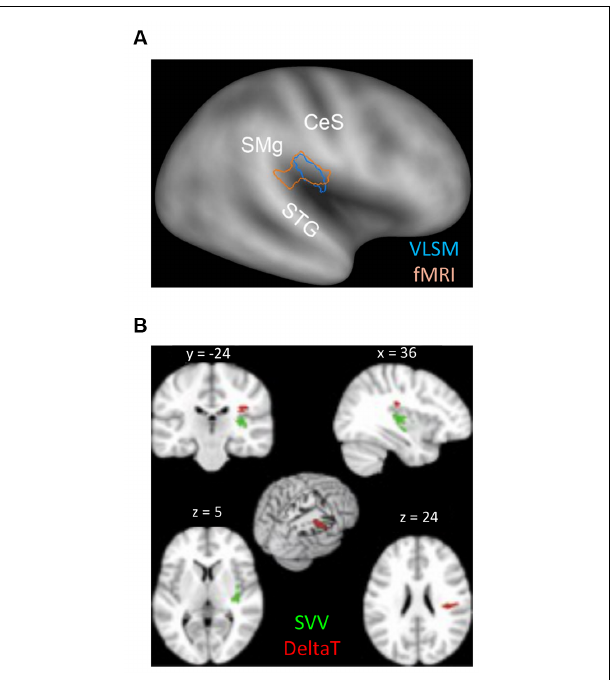
FIGURE 5 | (A) Overlap between the peri-sylvian region activated by the contrast (1 g > − 1 g ) in the fMRI study on healthy subjects (pink contour) and the lesion map resulting from the VLSM analysis performed by Maffei et al. (2016) (see text), which considered the lesioned brain regions associated with higher DeltaT values (blue contour). Contours are plotted onto the PALS inflated human brain template (Caret). CeS, Central Sulcus; STG, Superior Temporal Gyrus; SM, Supramarginal Gyrus. (B) Lesion Subtraction Map reported by Maffei et al. (2016). Red voxels were found to be damaged more frequently (>65%) in patients with the highest values of DeltaT ( n = 7) than in the seven patients with the smallest DeltaT values. Green voxels were found more frequently damaged (>65%) in patients with altered SVV estimation than in the five patients showing the smallest DeltaT values and intact SVV estimation. The MNI coordinates are reported on top of each brain section. Modified from Maffei et al. (2016). Cortex with permission of Roopa Lingayath, Senior Copyrights Coordinator ELSEVIER. SVV, subjective visual